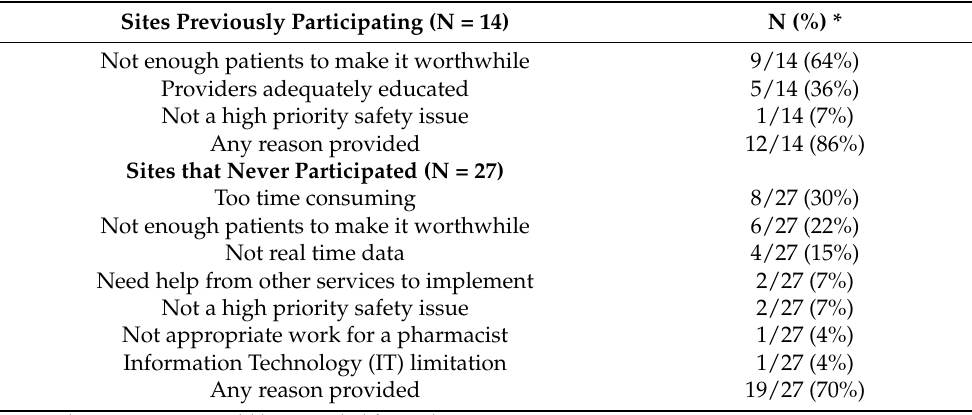
Table 2. Reasons for Lack of Participation in MUET Safety Program.